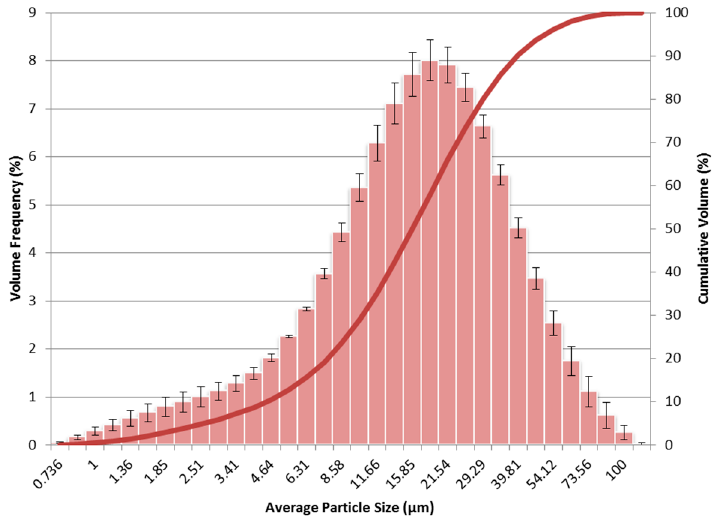
Figure 6. Average particle size histogram of percent sample volume. Standard Error bars are shown for each bin. The solid line represents the cumulative sample volume for a given step size and smaller.